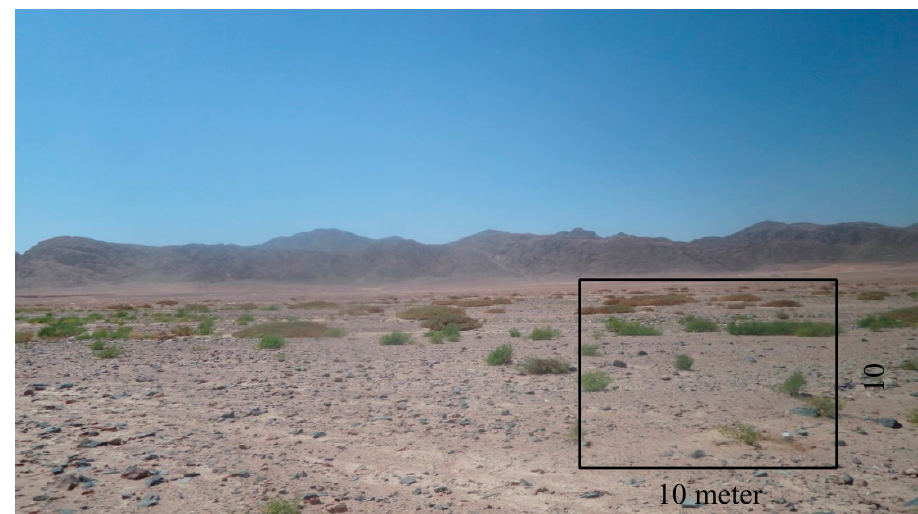
Figure 1. Location on the map showing the digital elevation model of Wadi Hagul.